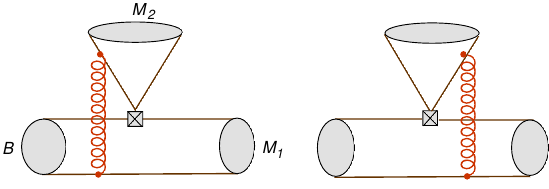
Figure 3 . NLO penguin contributions to the process B ! M 1 M 2 .